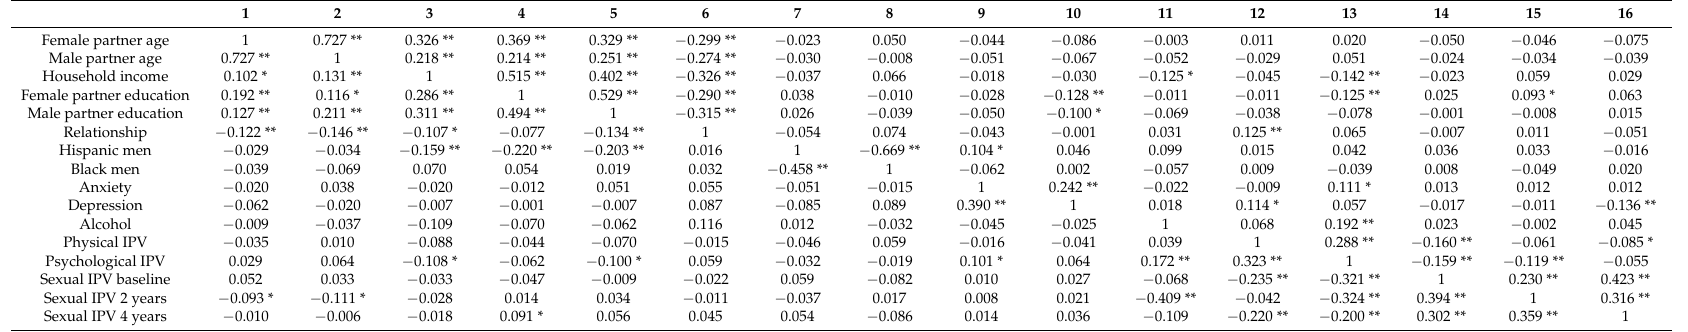
Table 4. Correlation matrix between male and female partners’